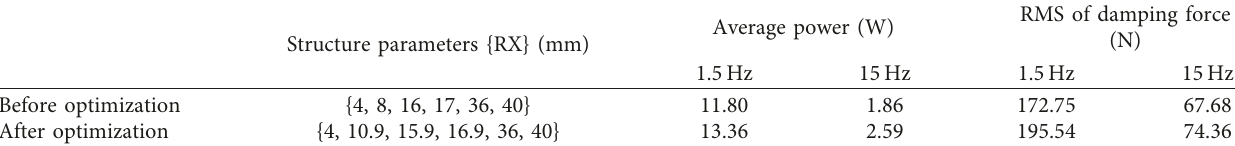
Table 1: Performance comparison before and after